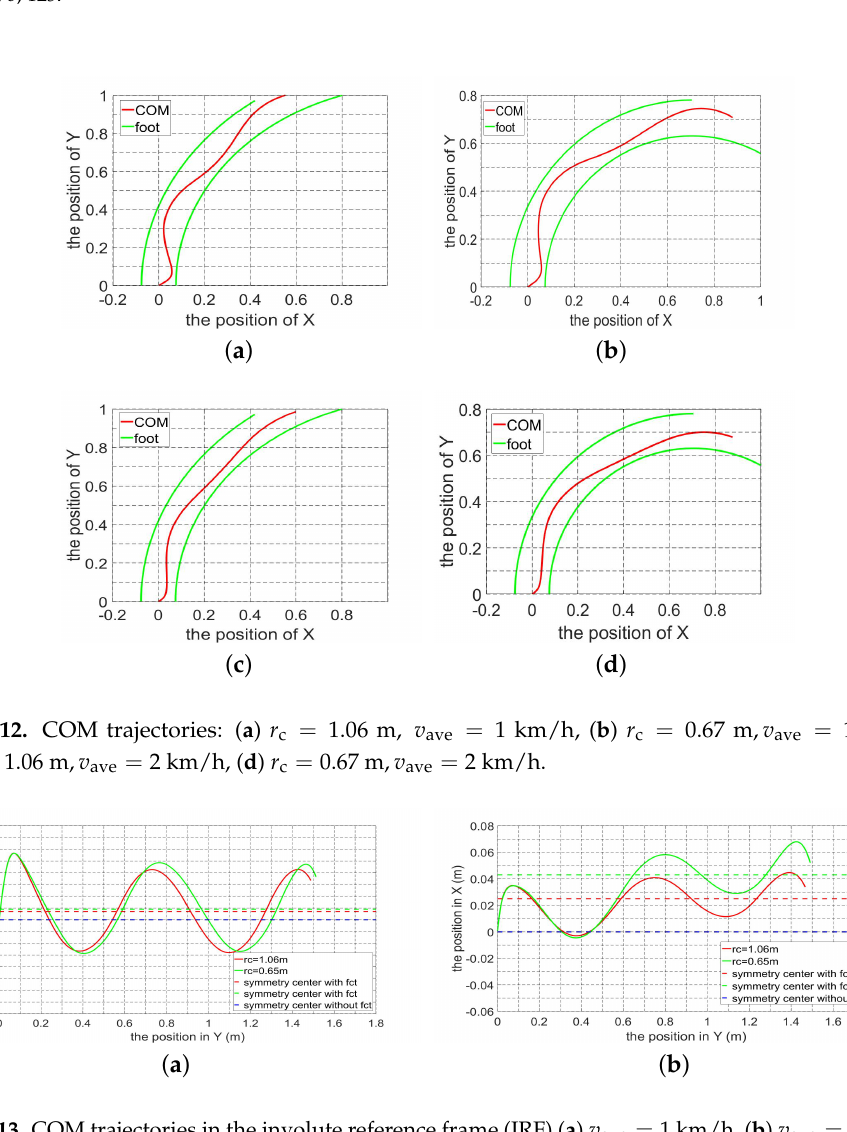
Figure 13. COM trajectories in the involute reference frame (IRF) ( a ) v ave = 1 km/h, ( b ) v ave = 2 km/h.